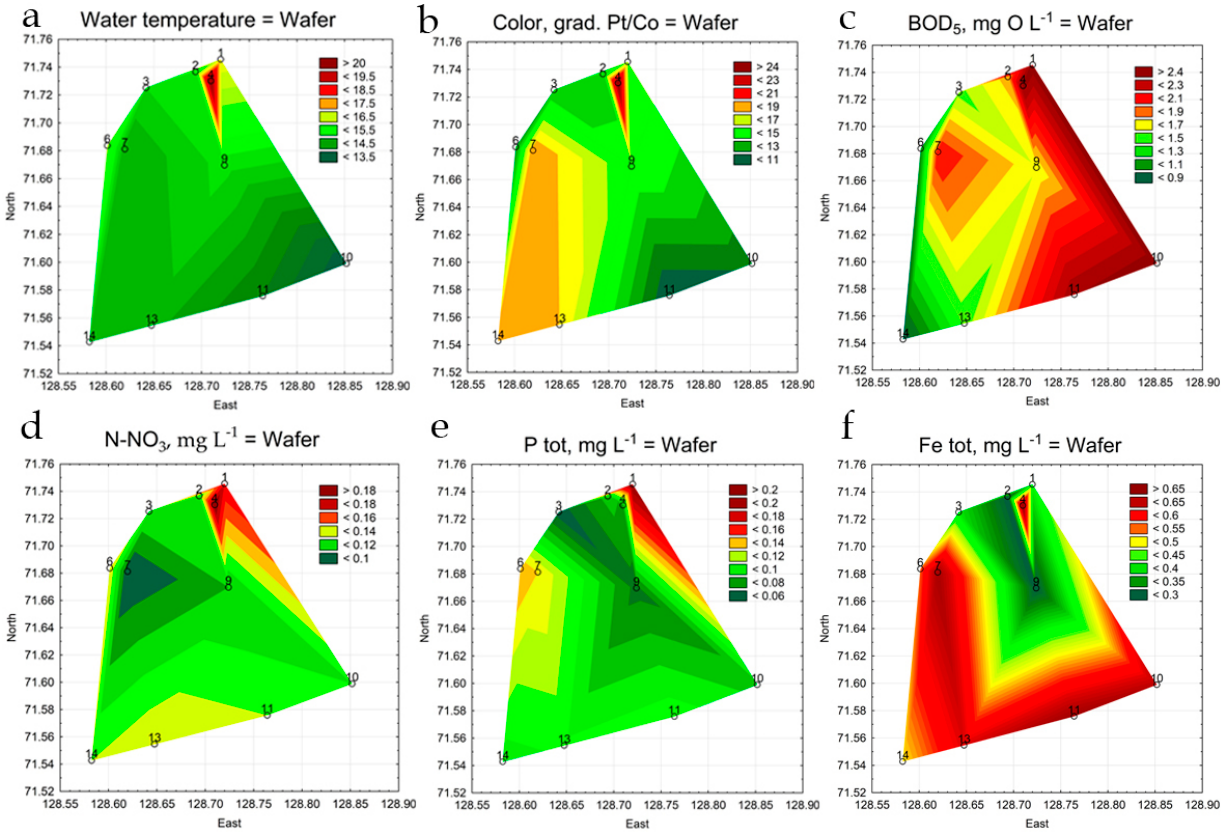
Figure 7. Statistical maps of environmental variables in the 11 studied water bodies: ( a ) water temperature; ( b ) water color; ( c ) BOD5; ( d ) N-NO3; ( e ) total P; ( f ) total Fe.